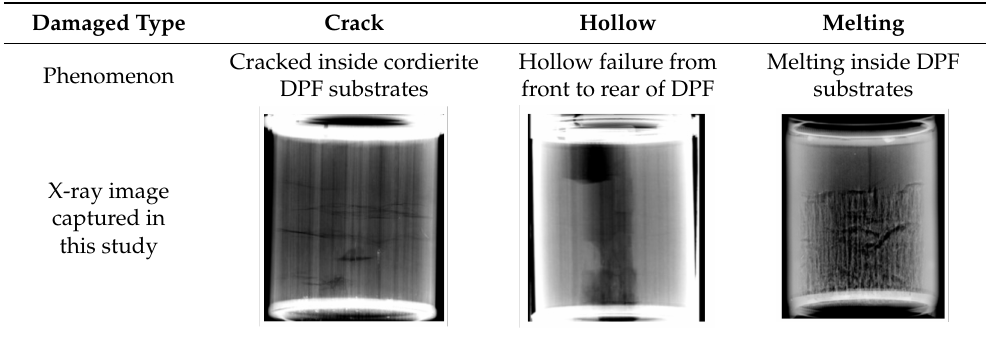
Table 4. Three types of DPF damage used in this